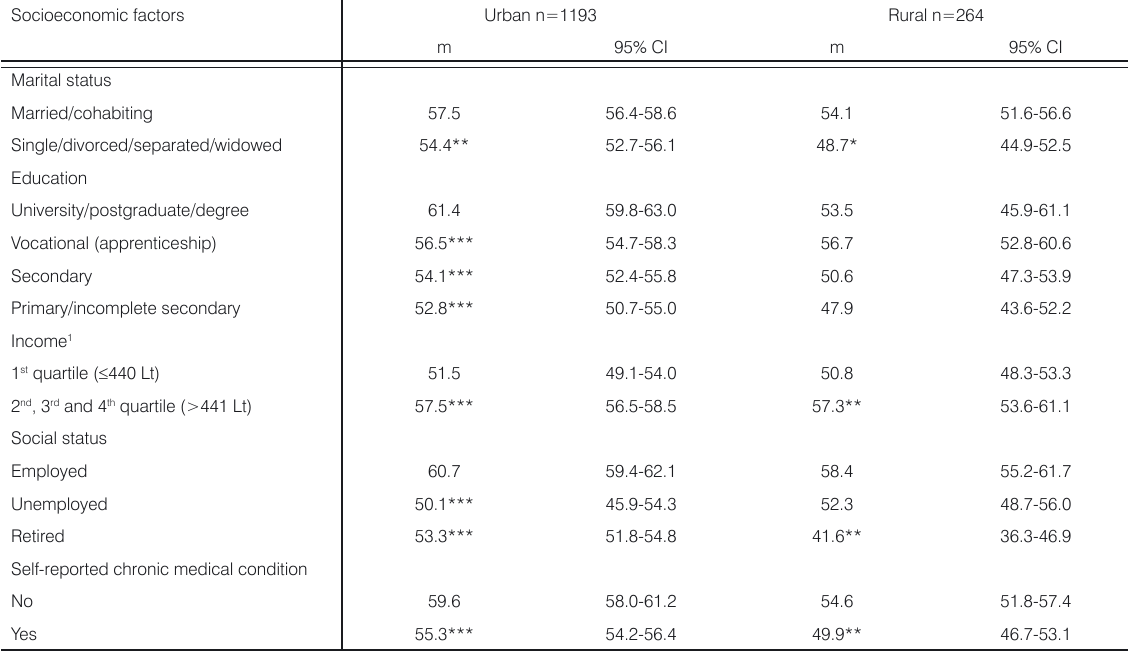
Table 2. Comparison of age and gender-adjusted mean scores of the overall quality of life across different socio-economic groups in urban and rural populations.